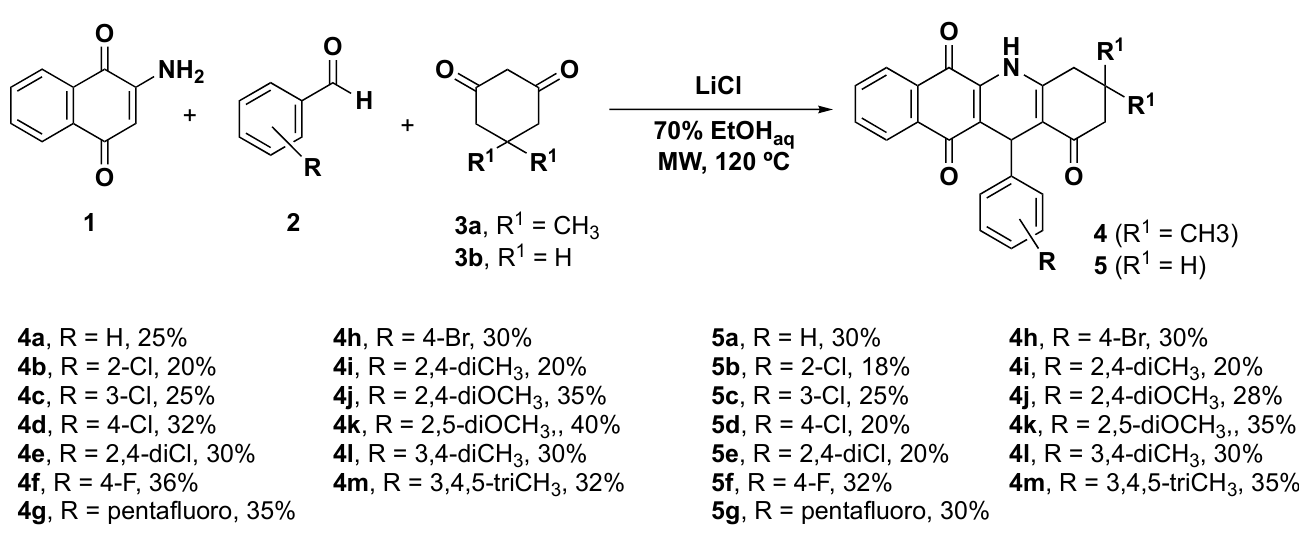
Scheme 1. Synthesis of acridine-core naphthoquinone compounds 4 and 5 .